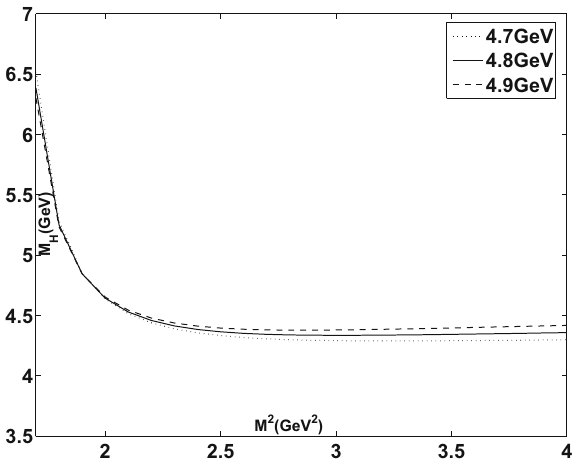
Fig. 6 The mass of (cid:2) c ¯ D state as a function of M 2 from sum rule (7). The continuum thresholds are taken as ranges of M 2 are 2 . 2 ∼ 2 . 9 GeV 2 for √ s 0 = 4 . 8 GeV, and 2 . 2 ∼ 3 . 2 GeV 2 for for